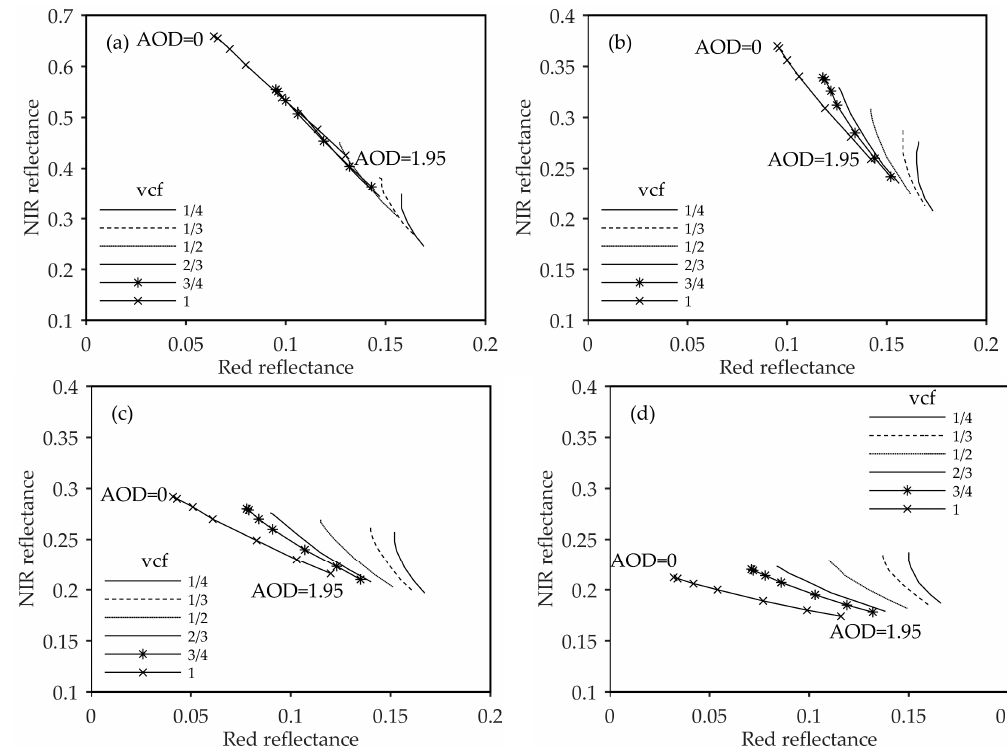
Figure 1. Simulated apparent reflectances as a function of aerosol optical depth and vegetation coverage fraction (vcf) for red (0.662 µ m) vs. NIR (0.835 µ m) channel. The AOD values depicted in the figures are for 550 nm. ( a ) Grass; ( b ) Shrub (Manzanita); ( c ) Arbor (Trembling Aspen); ( d ) Forest.